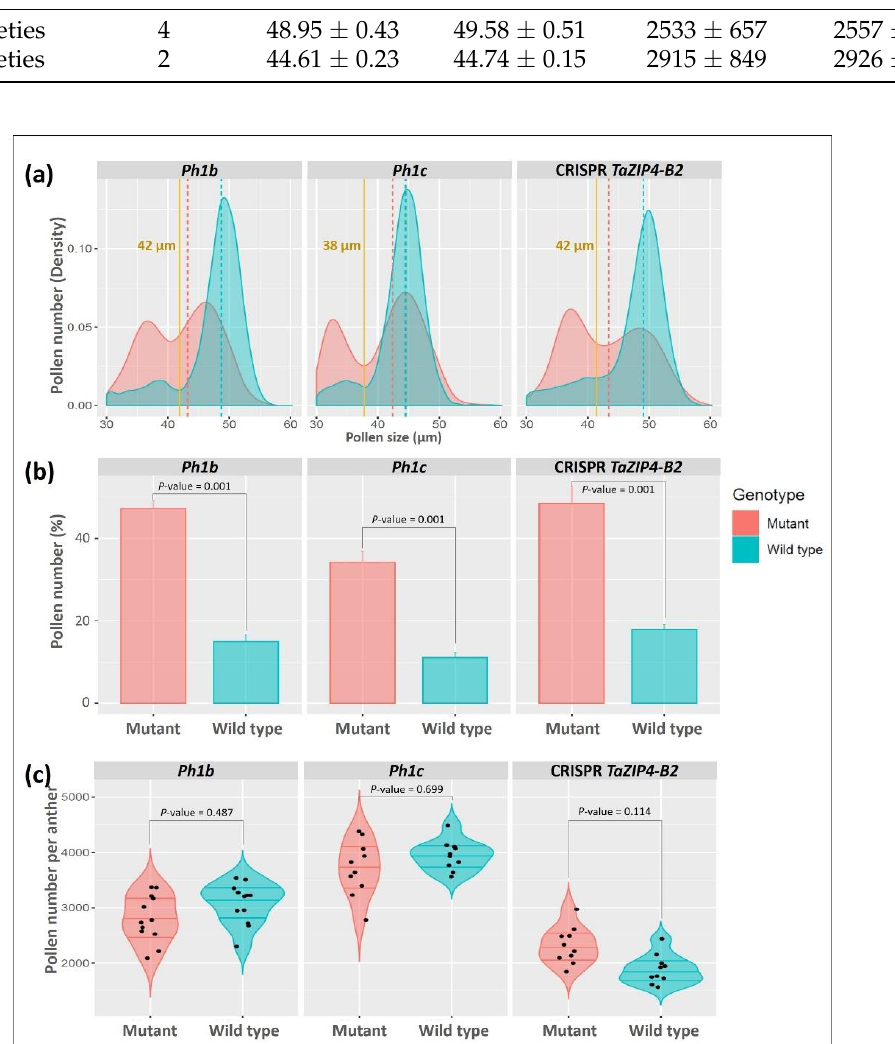
Figure 6. Pollen profiles of the three Tazip4-B2 mutants. ( a ) Density plot of the differential pollen size distribution data collected by coulter counter (Multisizer 4e) showing two distinguished peaks in all Tazip4-B2 mutants compared to their corresponding wild types. Dotted lines indicate the median pollen grain size for each genotype. Yellow lines indicate the borderline between normal and small pollen for each genotype group. ( b ) Percentages of small pollen grains for each genotype (mutants and wild types). Pollen grain is considered small when it is ≤42 μm and ≤38 µm for hexaploid and tetraploid wheat pollen size respectively. ( c ) Comparison of number of pollen grains per anther between each Tazip4-B2 mutant and its wild type. No significant difference in pollen number per anther was found between any of the mutants and its wild type.